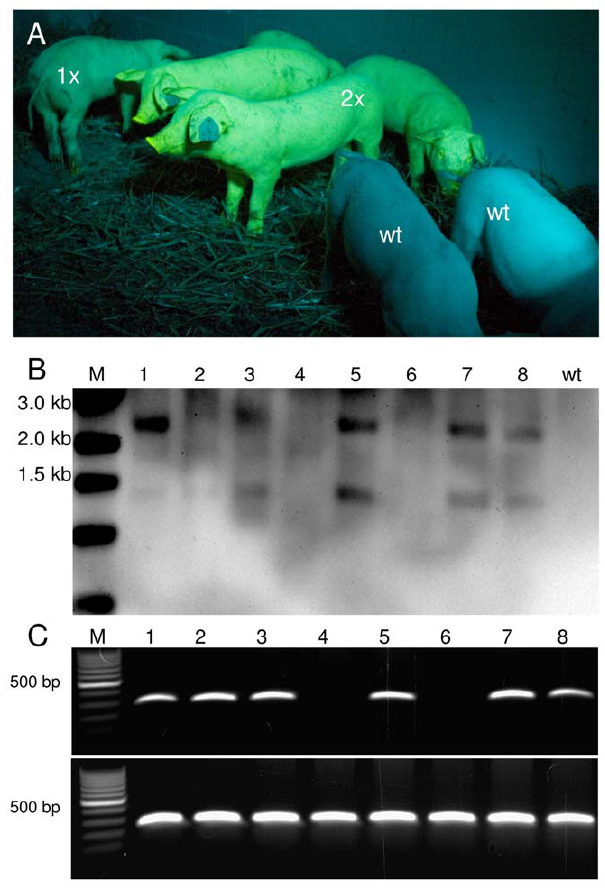
Figure 5. Segregation of Venus transposon in F1 offspring. A) F1-offspring viewed under specific excitation of Venus. Under the recording conditions, Venus fluorescence is displayed as green-yellow color, exemplarily some animals are labelled with their copy number of the transposon. Note that the copy numbers of the transposon correlated directly with the fluorescence intensity. The non-transgenic littermates (wt) appear bluish due to reflected and scattered excitation light B) Southern blot analysis of one litter. Lanes 1-3, 5, 7 and 8 represent transposon transgenic piglets with specific hybridization signals. Lanes 4 and 6 represent non-transgenic littermates. M, molecular size marker. C) PCR genotyping for the presence of the Venus transgene. As positive control, a PCR for polyA polymerase (PolyA) was included; wt, wild type sample.